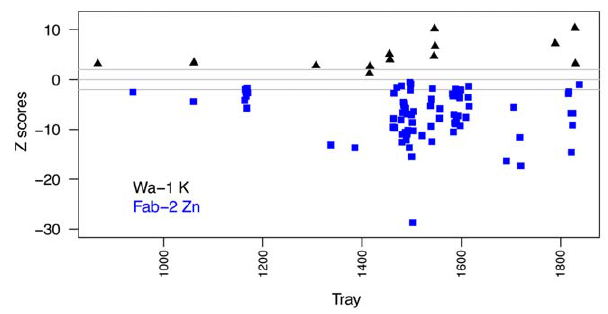
Figure 6. Z-score values of Wa-1 for K and Fab-2 for Zn across the ionomicshub.org database. Z-scores ([Line average – Control Average]/Control S.D.) compared to Col-0 in each tray for all instances where Wa-1 K (black triangle) or Fab-2 Zn (blue squares) were measured. Grey lines denote zscores of 2 2, 0, and 2.